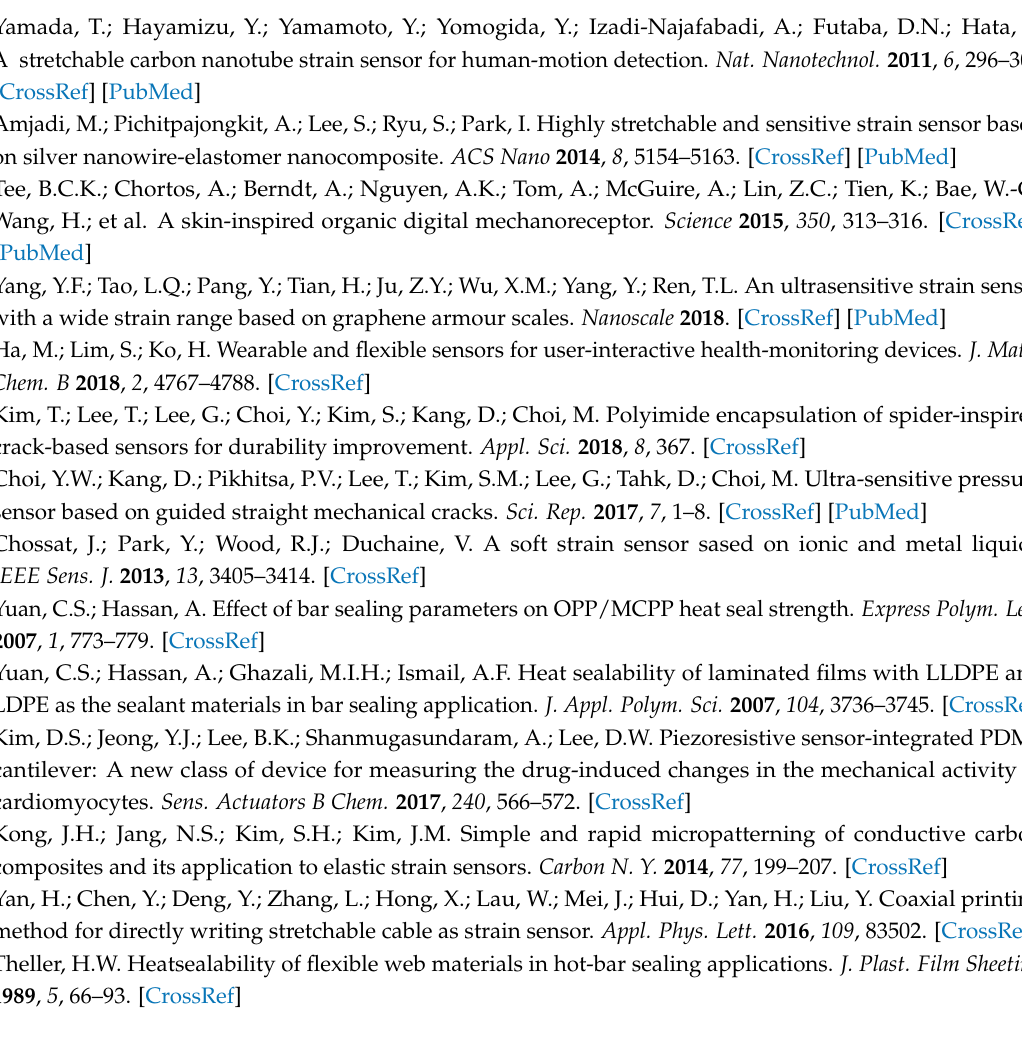
Supplementary Materials: The following are available online at http://www.mdpi.com/1424-8220/18/8/ 2673/s1, Figure S1: Sensor shape paper and PU model, Figure S2: Bonding strength by mechanical testing, Figures S3 and S4: Cross-sectional SEM image that was cut using the razor blade and the OLE method, Table S1: Cost estimation of the materials of OLE